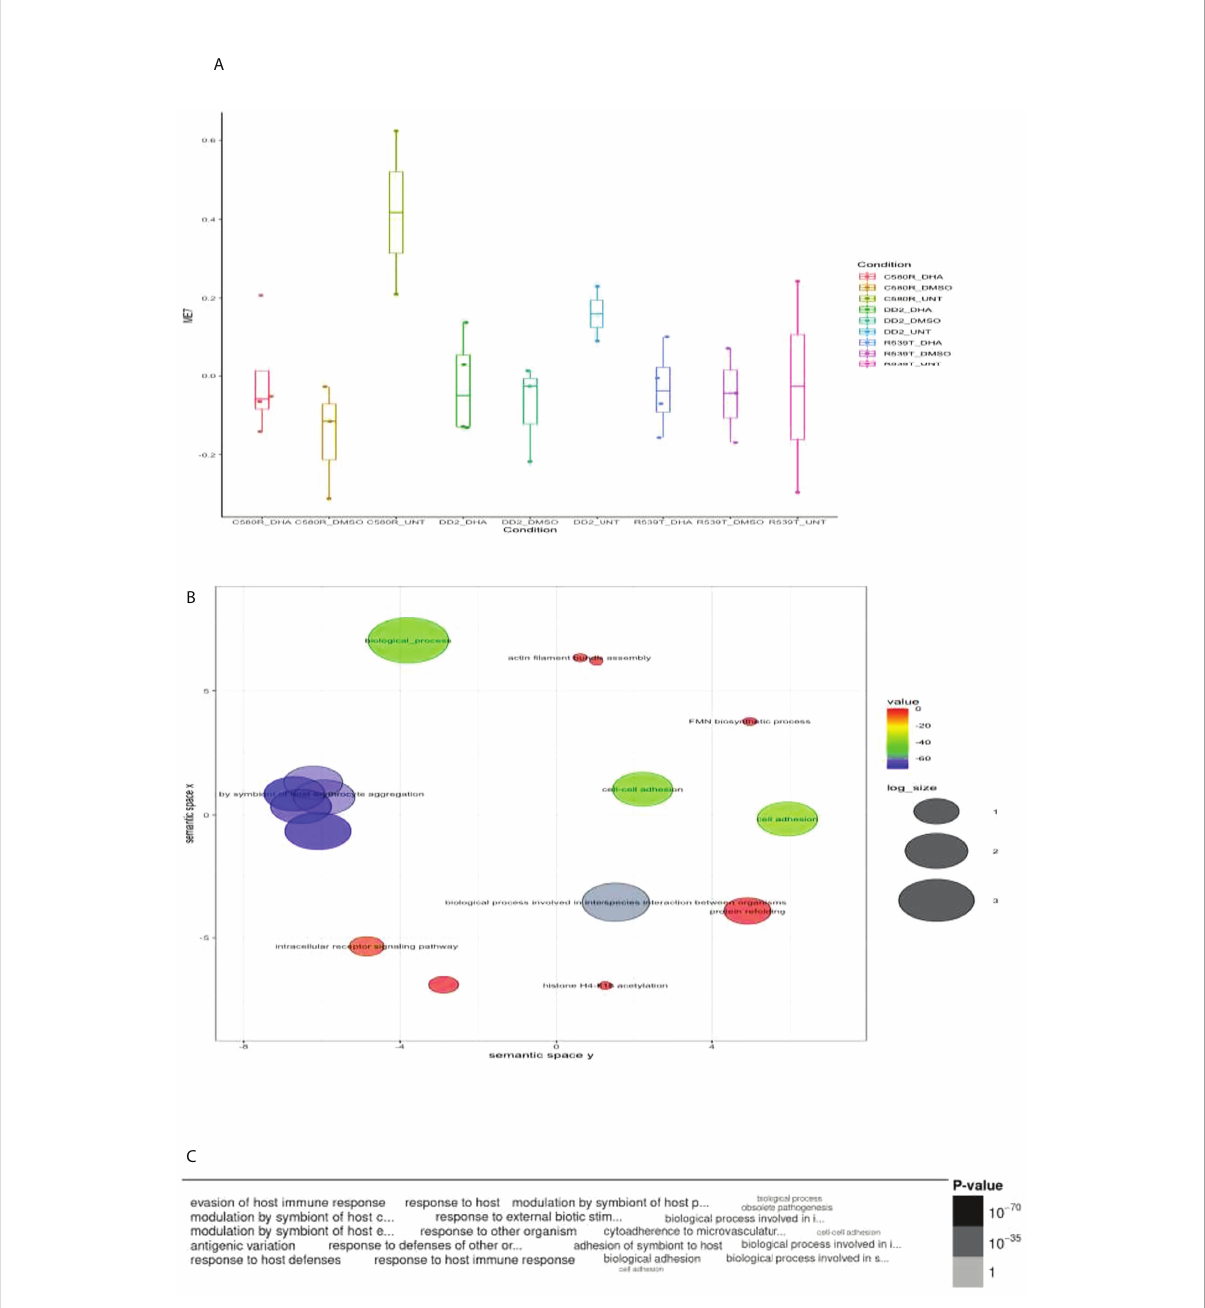
FIGURE 3 Properties of EVs module 7 (ME7). ME7 was uploaded to PlasmoDB(https://plasmodb.org/plasmo/app) and analyzed with the platform ’ s gene ontology (GO) pipeline. (A) Comparison of ME1 between the three treatment conditions pooled for all parasite lines (DD2, C580R and R539T). The Kruskal-Wallis test was used to determine the statistical signi fi cance of the difference in expression of ME7 among the conditions (p-value = 0.3606). (B) GO (biological processes) output for ME7 summarized using REVIGO (http://revigo.irb.hr) scatterplot visualization option. Each circle denotes the representative cluster of the GO biological process associated with the ARTr phenotype and is derived by multidimensional scaling and redundancy reduction of the GO sematic similarities. The size of the circles denote the frequency of the GO term in the P. falciparum GO database (updated in November 2021) with larger circles denoting more general terms. The colors (red to blue range) indicate the statistical signi fi cance of the association ’ s strength. “ Modulation by symbiont of host erythrocyte aggregation ” was one of the biological processes enriched (C) Word cloud summary of the GO biological processes associated with the ARTr phenotype. EVs, extracellular vesicles; ARTr, artemisinin